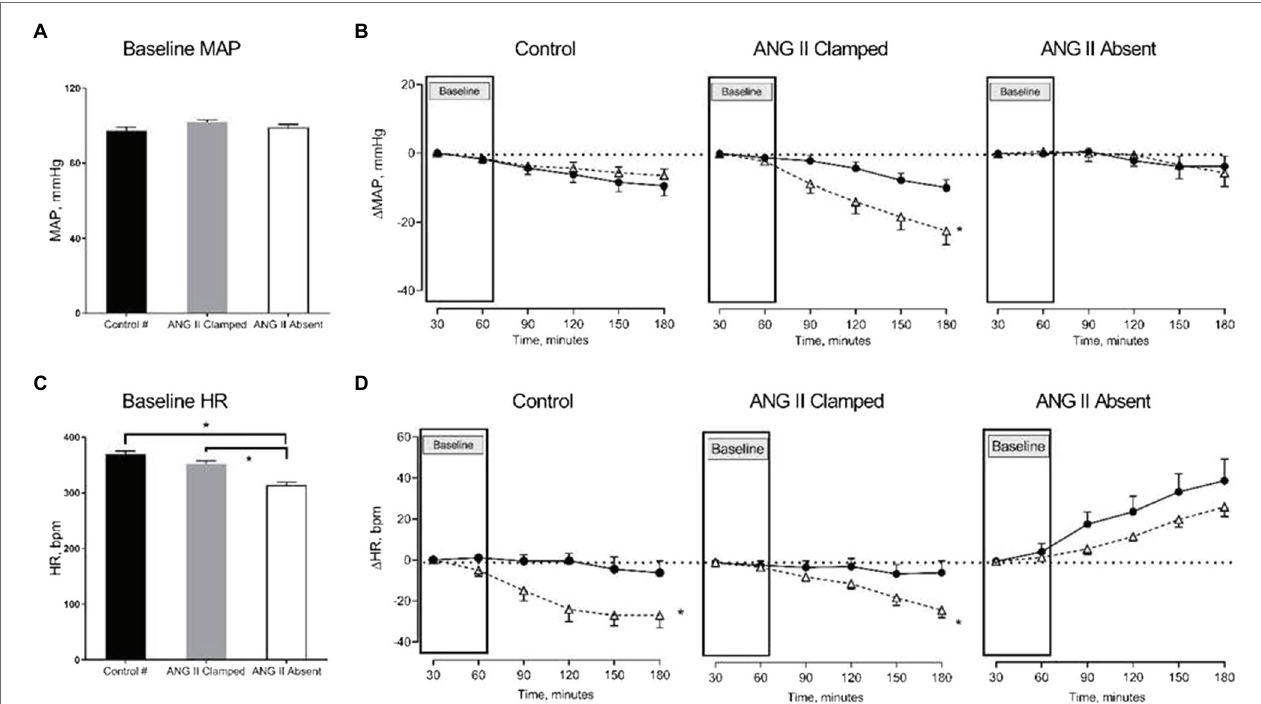
FIGURE 1 | Changes in mean arterial pressure (MAP) and heart rate (HR) in response to increased renal venous pressure (RVP). The bar graphs show the baseline MAP (A) and HR (C) in untreated control (black, control, n = 8), angiotensin II (ANG II) Clamp (grey, ANG II Clamp, n = 10) and ANG II Absent (open bar, ANG II Absent, n = 8, BP supported by AVP) rats. The line charts represent changes from baseline, △ MAP (B) , and △ HR (D) . In the line chart, the first two time points in each line represent baseline. The latter four time points show control ( ● , control) and major RVP elevation ( △ , RVP20). Baseline MAP did not differ among groups (A) . Increased RVP caused a significant decrease in MAP in the ANG II Clamp group ( B ; * p < 0.05) but not in untreated control group or ANG II Absent group. Baseline HR was significantly lower in the ANG II Absent group than in untreated control and ANG II Clamp groups ( C ; * p < 0.05). Increased RVP induced HR reduction in untreated control group and ANG II Clamp group (* p < 0.05) but not in the ANG II Absent group (D) . # Data from these were published in Huang et al.